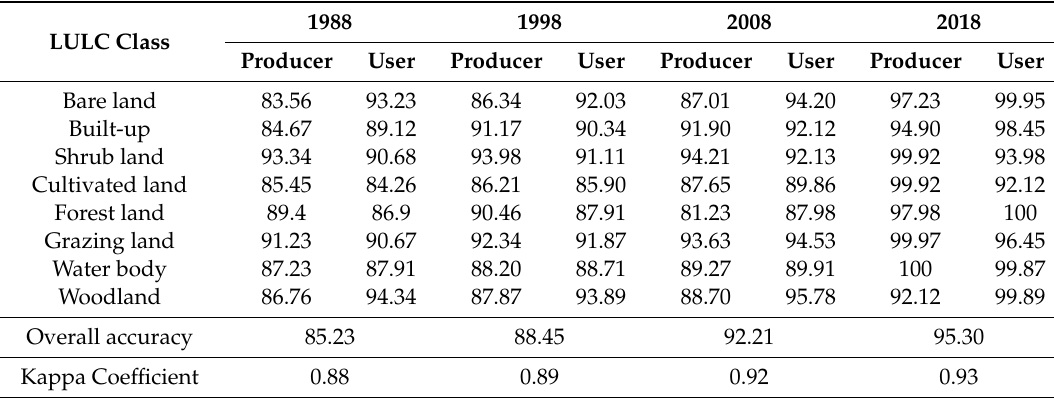
Table 9. Confusion matrix for classified images.